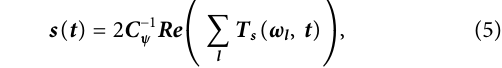
Frontiers in Earth Science |